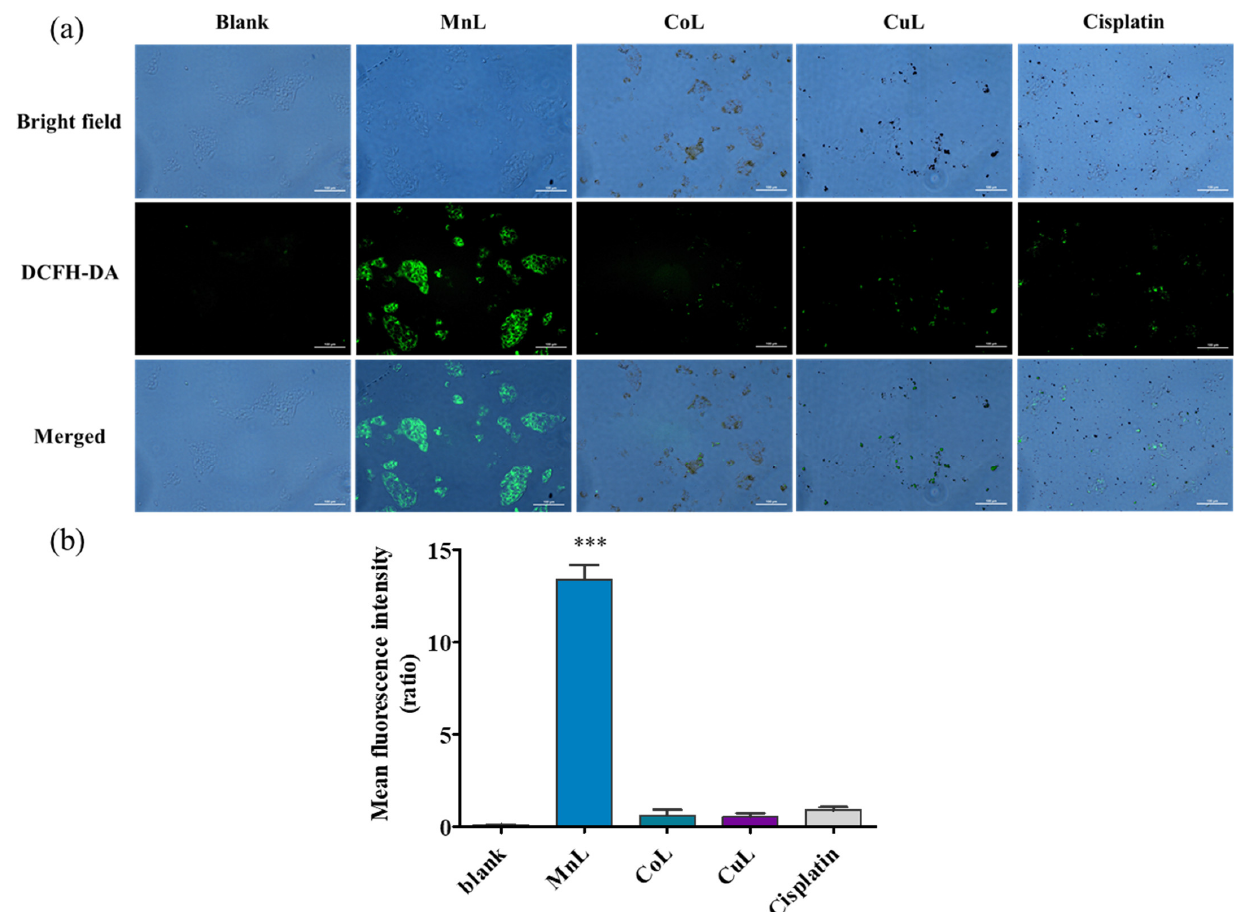
Figure 5. DCFH-DA staining to detect ROS in HepG2 cells treated with metal complexes. HepG2 cells were stained with DCFH-DA after 24 h of incubation with and without the metal complexes (blank: untreated group; metal complexes MnL , CoL , CuL , and cisplatin: IC 50 values). ( a ) Representative micrographs for metal complexes and control. ( b ) Quantified ROS production data. The results are reported as the mean ± SEM ( n = 3). *** p < 0.001 relatives to the blank. Table 2. Predicted binding energies for L , MnL , and BTA with various DNA configurations.